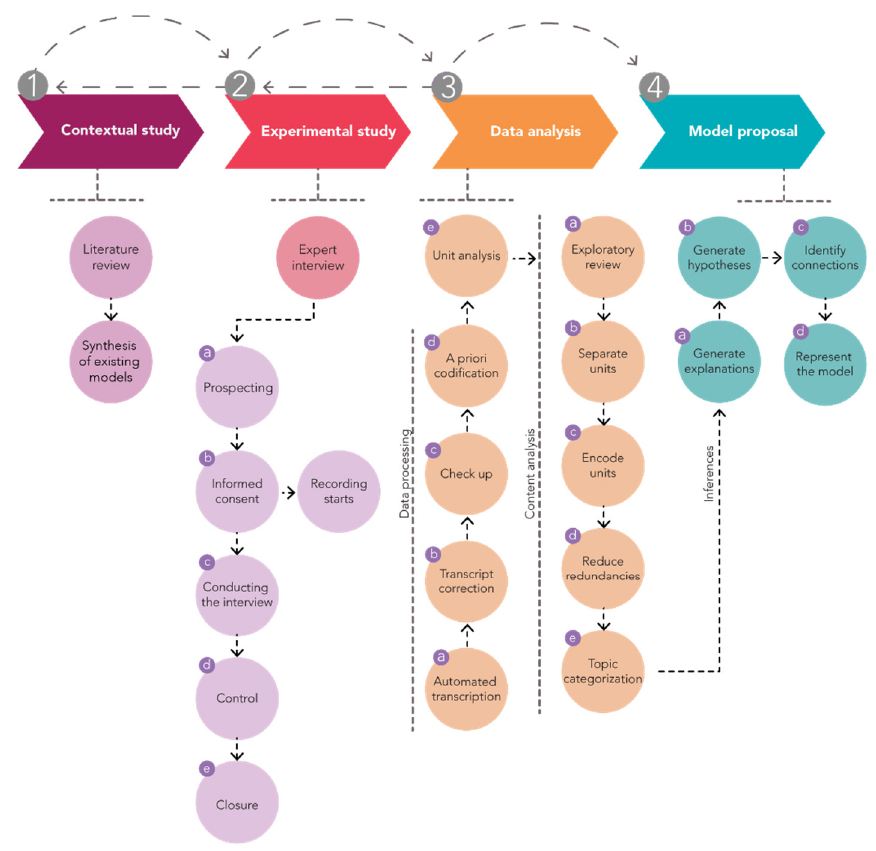
Figure 1. Methodological scheme (own elaboration).